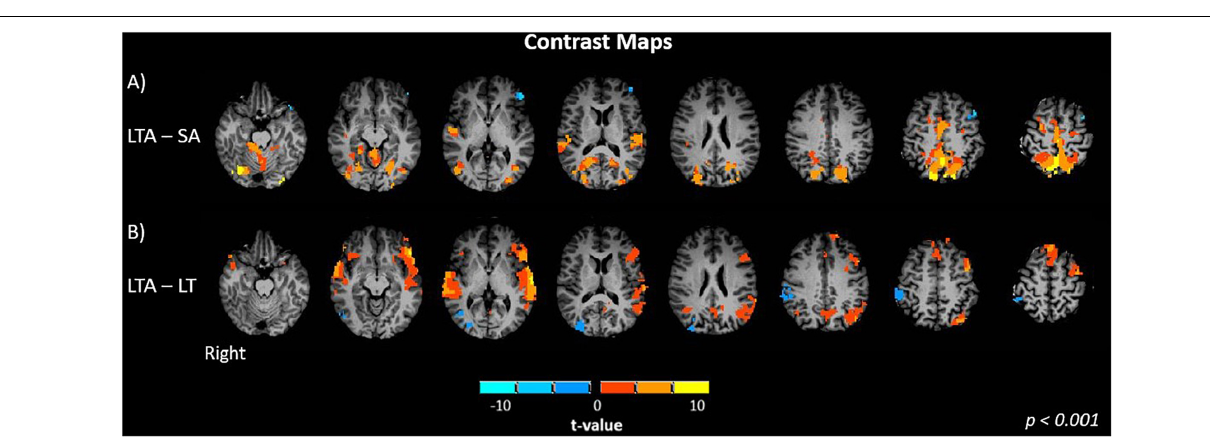
FIGURE 4 | Brain activation maps of contrast between task factors: (A) LTA – SA, Left turns with oncoming traffic and audio vs. straight driving with audio; and (B) LTA – L, left turns with oncoming traffic and audio vs. left turns with oncoming traffic without audio. Activations are shown with a statistical significance threshold of p < 0.001. “Right” indicates the right cerebral